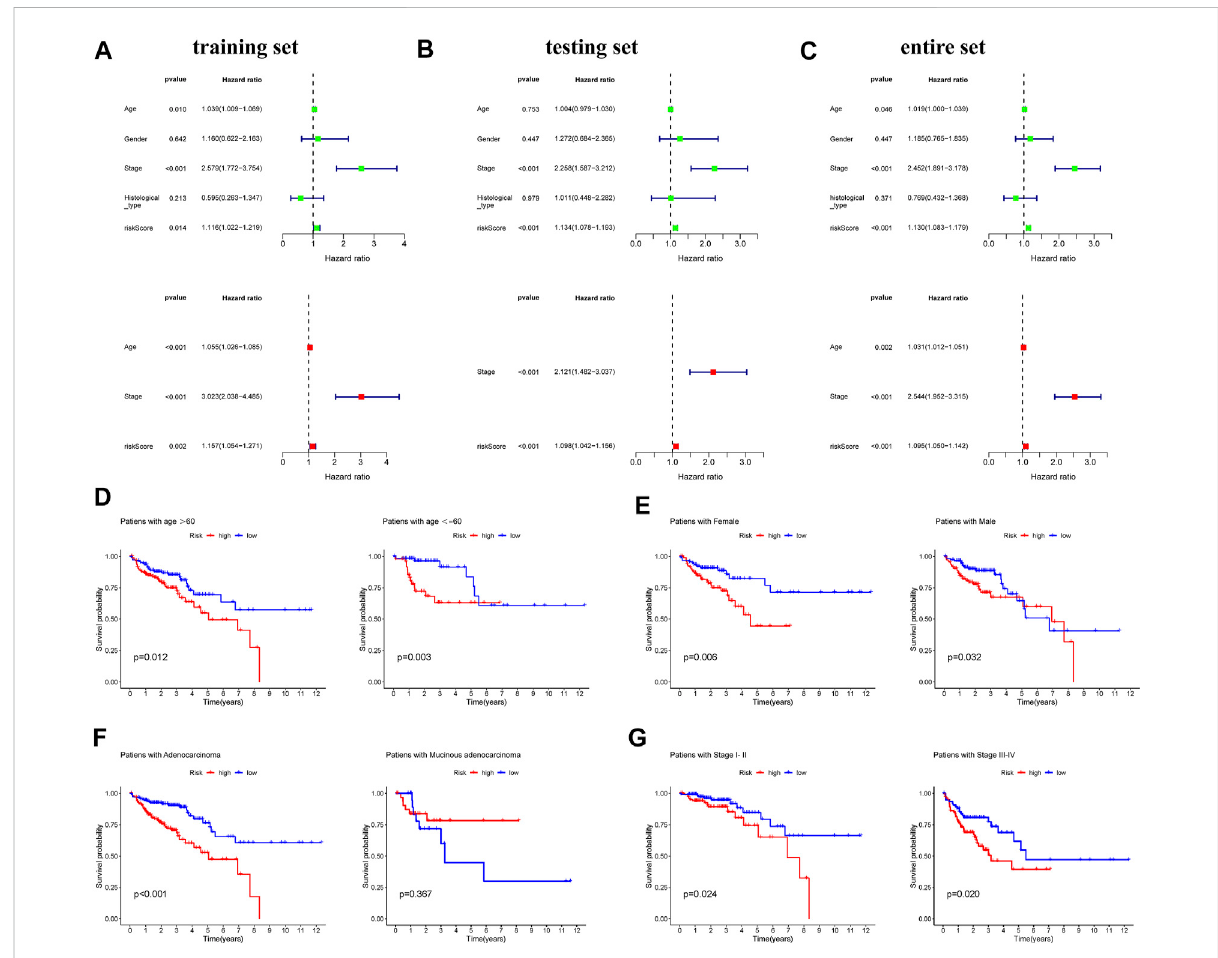
FIGURE 3 Analyses of the independent predictor of COAD patients. Univariate and multivariate COX regression analysis of clinical factors (age, gender, stage,histologicaltypes,andriskscore)inthetrainingset (A) ,testingset (B) ,andentireset (C) .Kapan-Meiersurvivalcurvesrevealprognosticvalueof risk score in COAD patients with different ages (D) , genders (E) , histological types (F) , and stages (G)